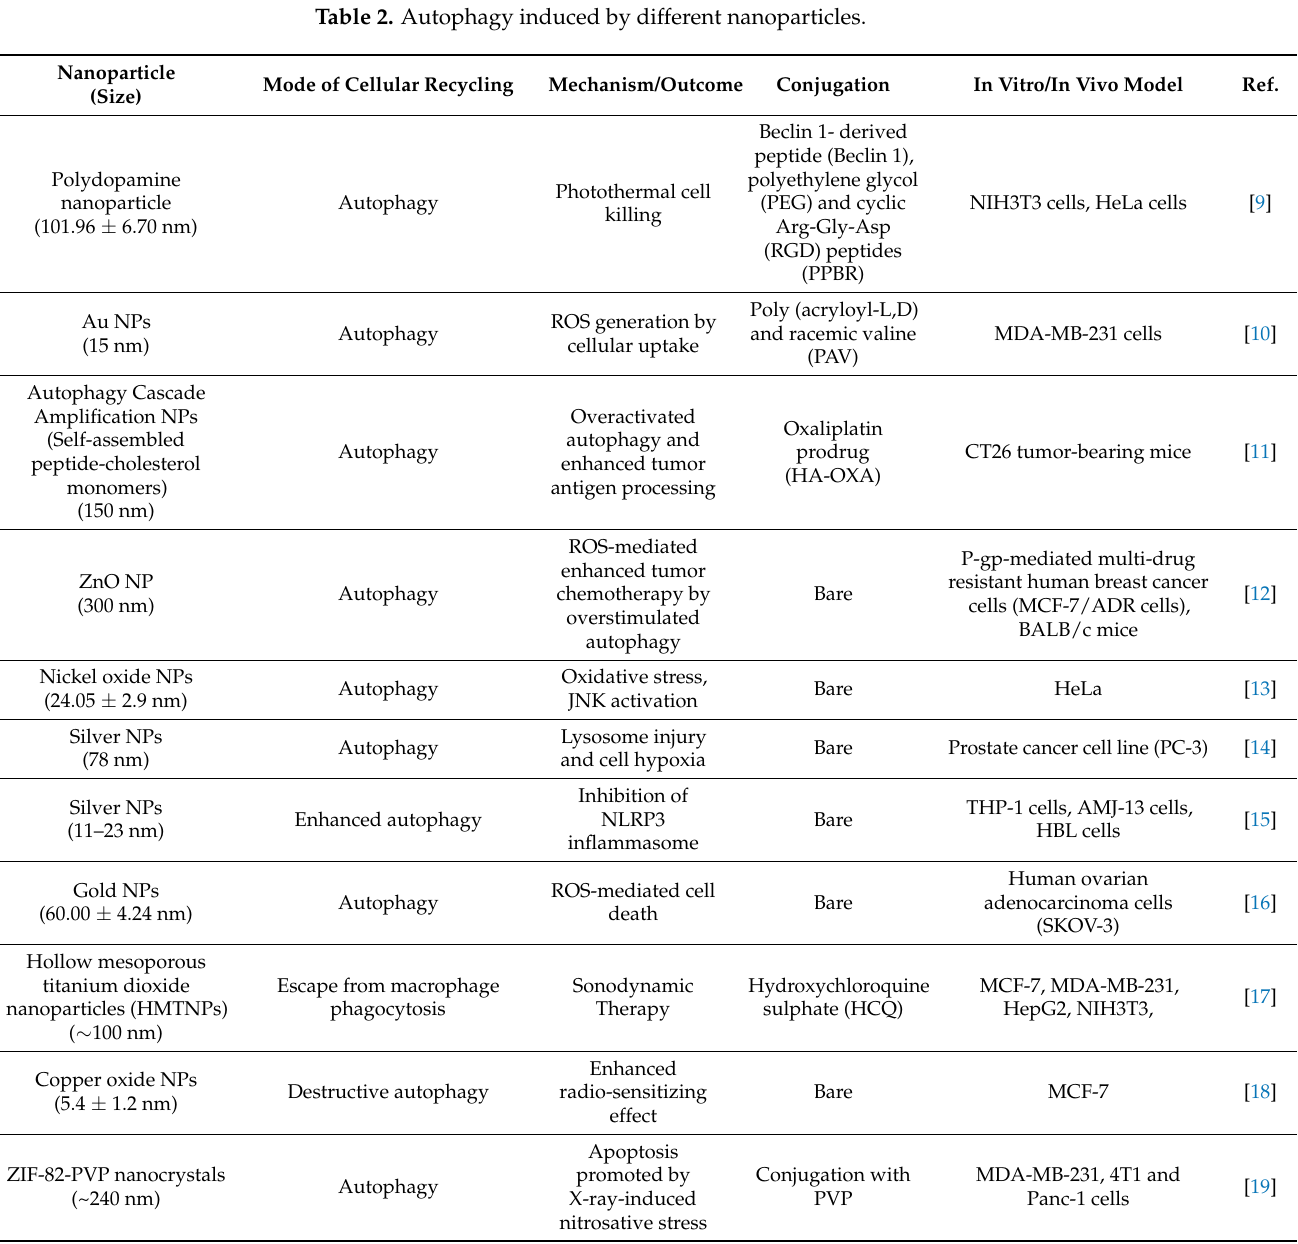
Table 1. Cont. Similarities Activation of similar molecular machinery (i.e., BECN1, ULK1/2, LC3) Generation of ROS molecules can act as a trigger for both processes Both processes result in cellular damage and apoptosis Essential for quality control of the cells’ defense mechanism Both processes are forms of degradation mechanisms rather than cell death mechanisms (unlike apoptosis).